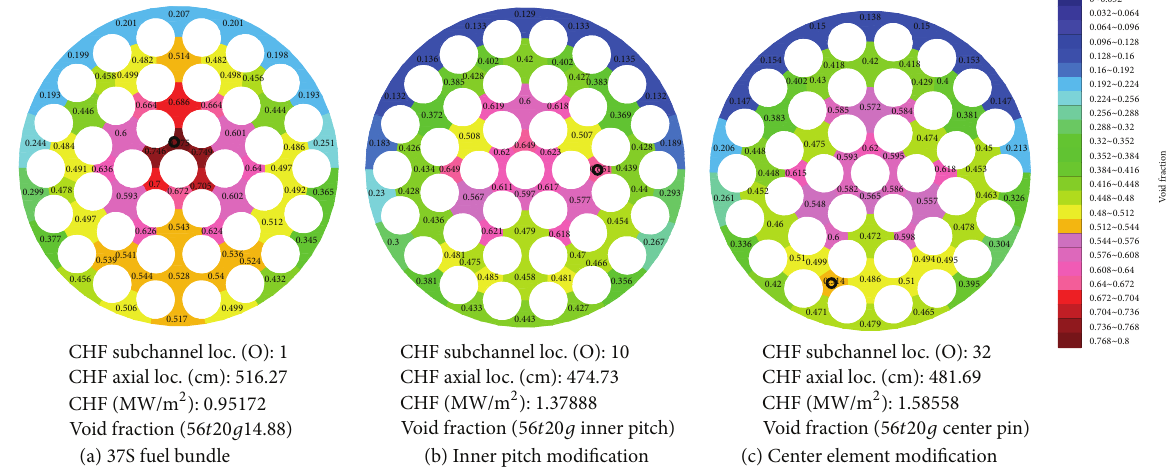
Figure 10: Void fraction distributions of the standard 37-element fuel and its modifications at 256 ∘ C.